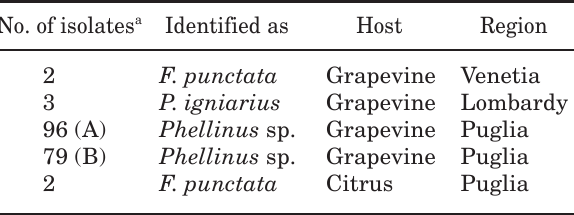
Table 1. Fungal isolates investigated with PCR-RAPD